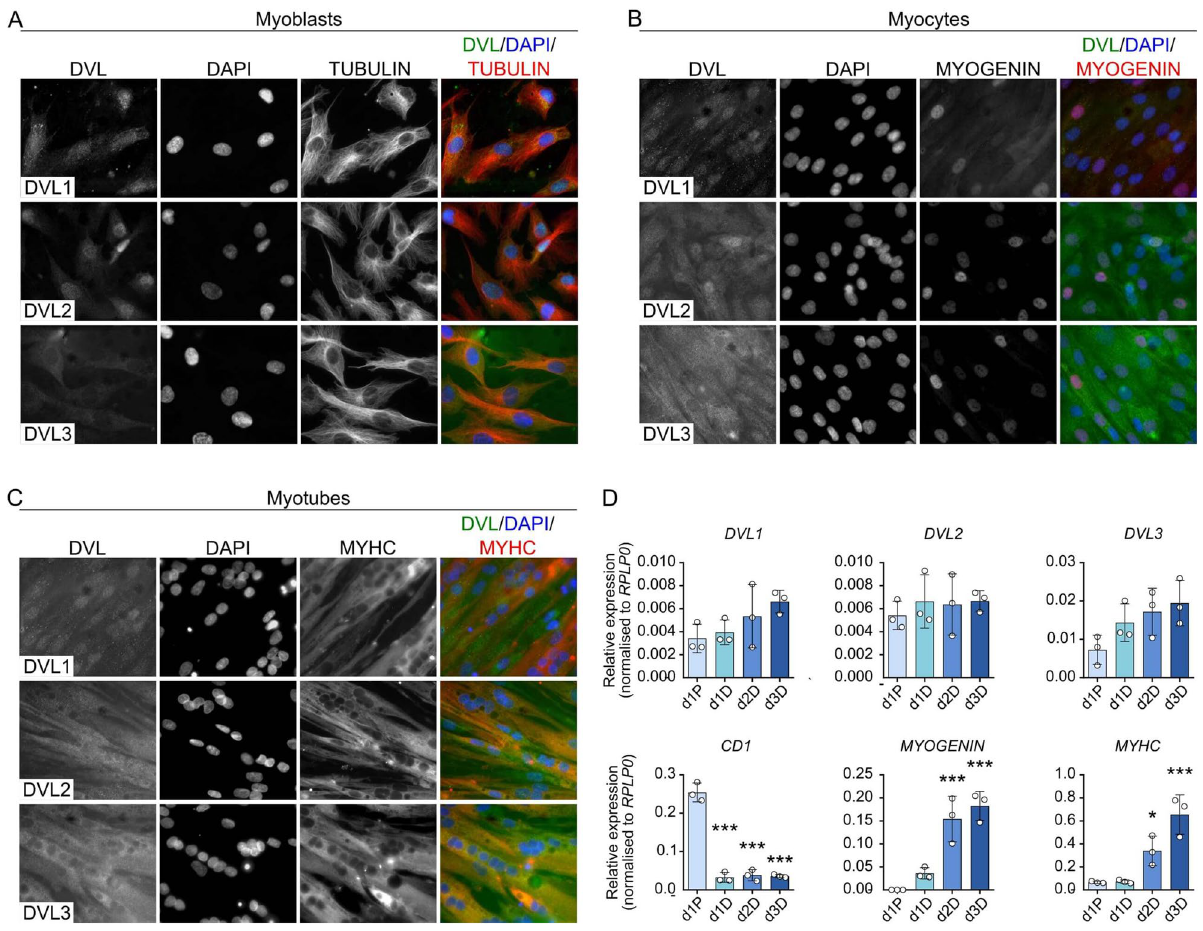
Figure 1. Localisation and expression profile of DVL1-3 during human skeletal myogenesis. ( A ) Localisation of DVL1-3 in proliferating human C25 myoblasts. ( B ) Localisation of DVL isoforms in C25 myoblasts after two days of differentiation and ( C ) localisation of DVL1-3 isoforms in multinucleated C25 myotubes after three days of differentiation. ( D ) Gene expression profile for DVL1-3, proliferation marker CD1 and early (MYOGENIN) and late (MyHC: MYH3, MYH8 and MYH2) differentiation markers in C25 myoblasts on day (d) 1 in proliferation (d1P) and on days (d) 1, 2 and 3 of differentiation (d1D, d2D and d3D). Data is represented as mean ± SD. N = 3, statistically significant differences were assessed using a One-WAY ANOVA with Dunett’s post hoc test, comparing each time-point to proliferation where an asterisk denotes p < 0.05 and three asterisks denote p <